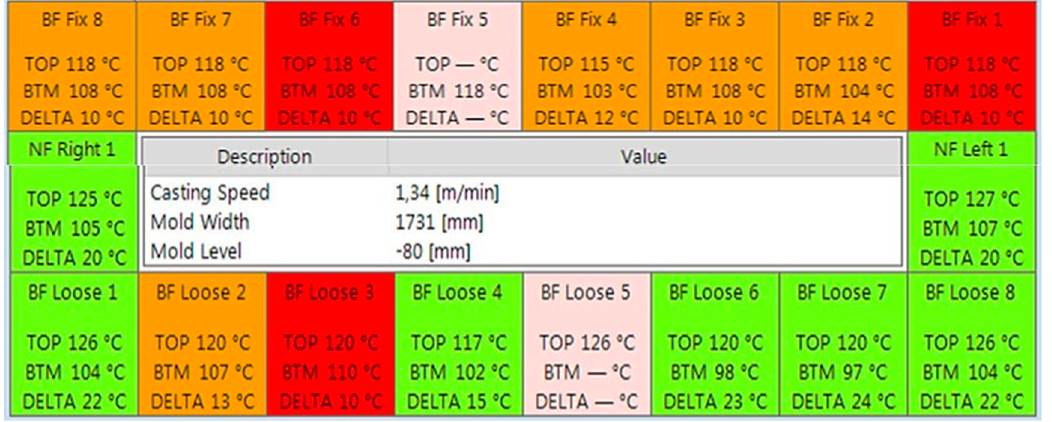
Table 2. Technical data of mold. Types of Design